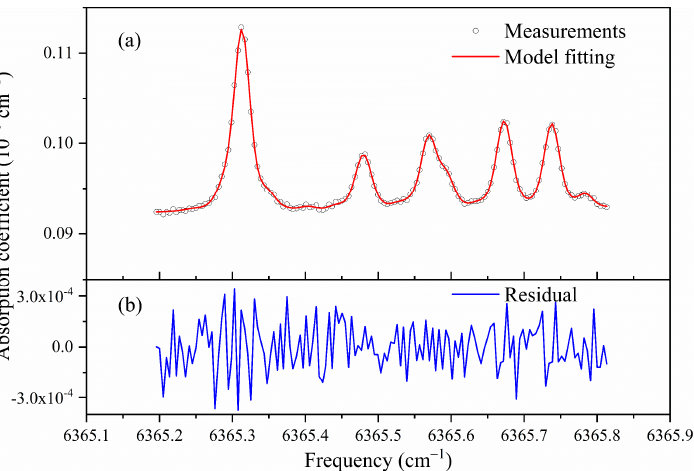
Figure 6. ( a ) A CH4 absorption spectrum measured at discrete frequency points of cavity resonances, together with spectral modelling. ( b ) The established CH4 wavelengths help to determine the cavity mode spacing (i.e., its free spectral range—FSR).